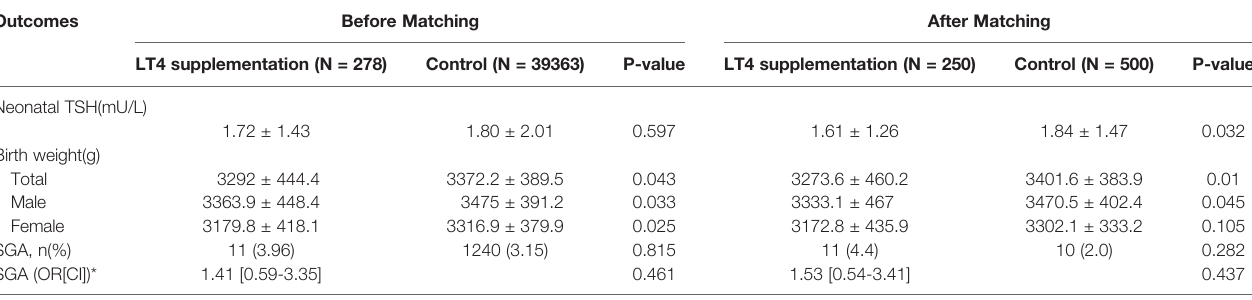
TABLE 3 | Differences of neonatal outcomes before and after propensity score matching. Outcomes Before